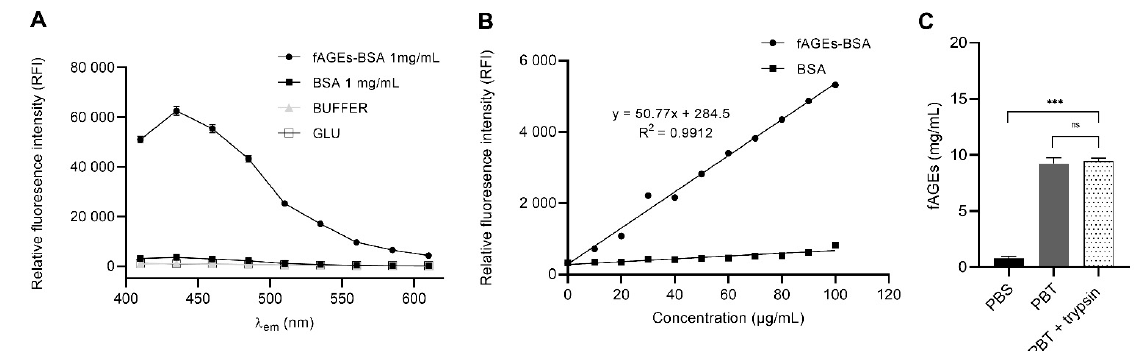
Figure 1. Quantification of fluorescent Advanced Glycation End products (fAGEs)in vivo from whole body samples based on in vitro hydrothermal synthesis of standard calibrator fAGEs-BSA (bovine serum albumin). ( A ) The fluorescence emission spectrum was recorded at 410–610 nm, using an excitation wavelength of 360 nm. 200 µ L of samples: fAGEs-BSA, BSA, glucose and Na 2 HPO 4 buffer, was measured in triplicate and shown as mean ± standard error mean (SEM). ( B ) Calibration curve for fAGEs-BSA and BSA alone as control in µ g/mL concentration range with relative fluorescence intensity (RFI) recorded at λ ex 360 nm; λ em 440 nm ( r = 0.9956; n = 11, in triplicate; Pearson’s correlation) and linear regression y = 50.77x + 284.5; R 2 = 0.9912. ( C ) in vivo quantification of fAGEs in the whole body homogenates of Drosophila males ( n = 9) measured in triplicates, plotted as mean ± SEM for each of three conditions. Samples were prepared using: PBS buffer for the extraction of the extracellular proteins, PBT buffer for the extraction of the extracellular and cytosolic proteins, PBT + trypsin buffer for the proteolysis of the total extracellular and cytosolic proteins. Significant values: ***: p < 0.001 and non-significant (ns).